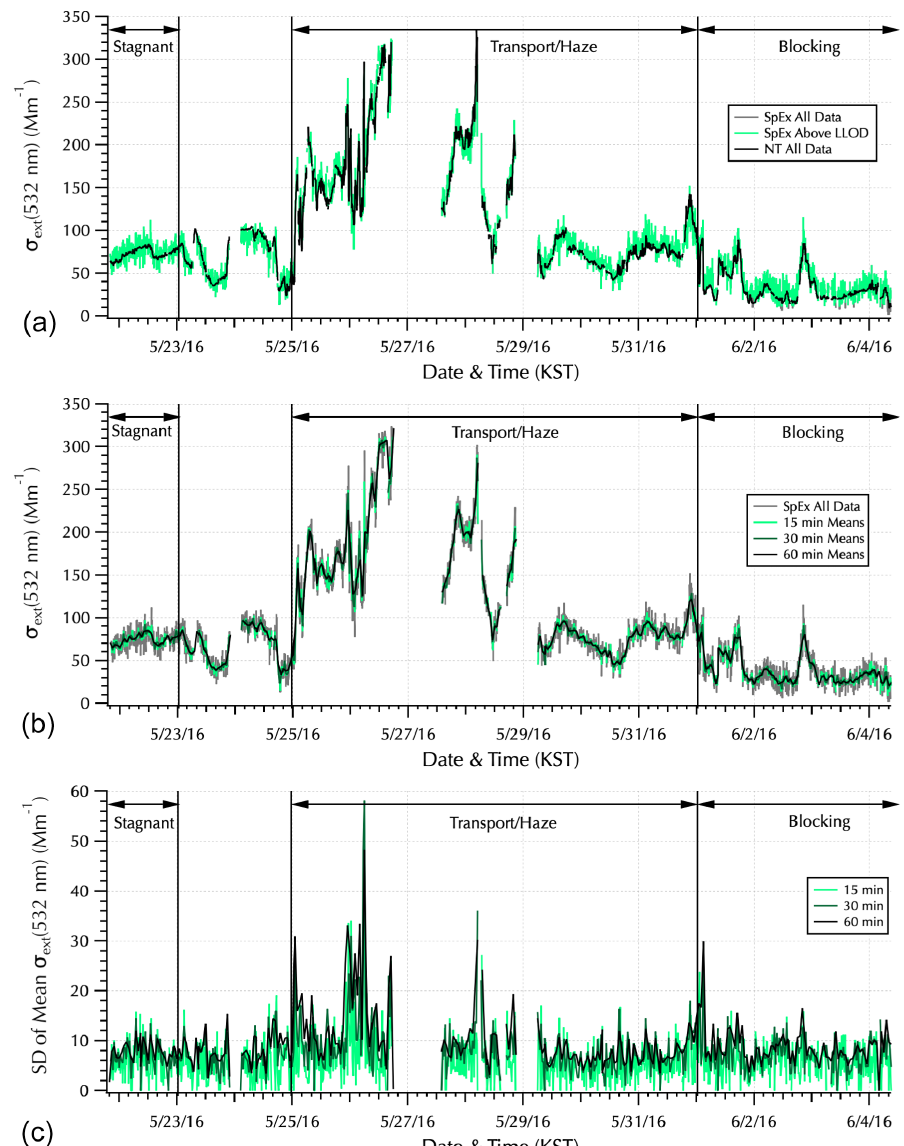
Figure 4. Time series of 532nm σ ext (Mm − 1 ) throughout the cruise. (a) SpEx (all data, gray; above LLOD, green; these curves are coincident until 2 June when the lowest values are below detection and hence appear gray) with NT σ ext (black). (b) SpEx (all data, gray) with 15min (light green), 30min (dark green), and 60min (black) means. (c) SpEx SDs of the 15min (light green), 30min (dark green), and 60min (black) means. Meteorological periods shown as in Fig.